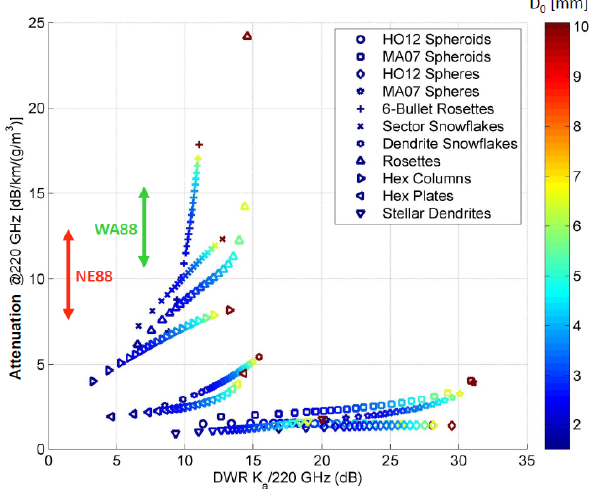
Figure 15. Snow attenuation per unit mass at 220GHz for differ- ent snow particle habits and PSDs (as indicated by the different colours), plotted against K a –220GHz DWR. Ranges of snow at- tenuation measured by Wallace (1988) and Nemarich et al. (1988) are illustrated by the arrows.